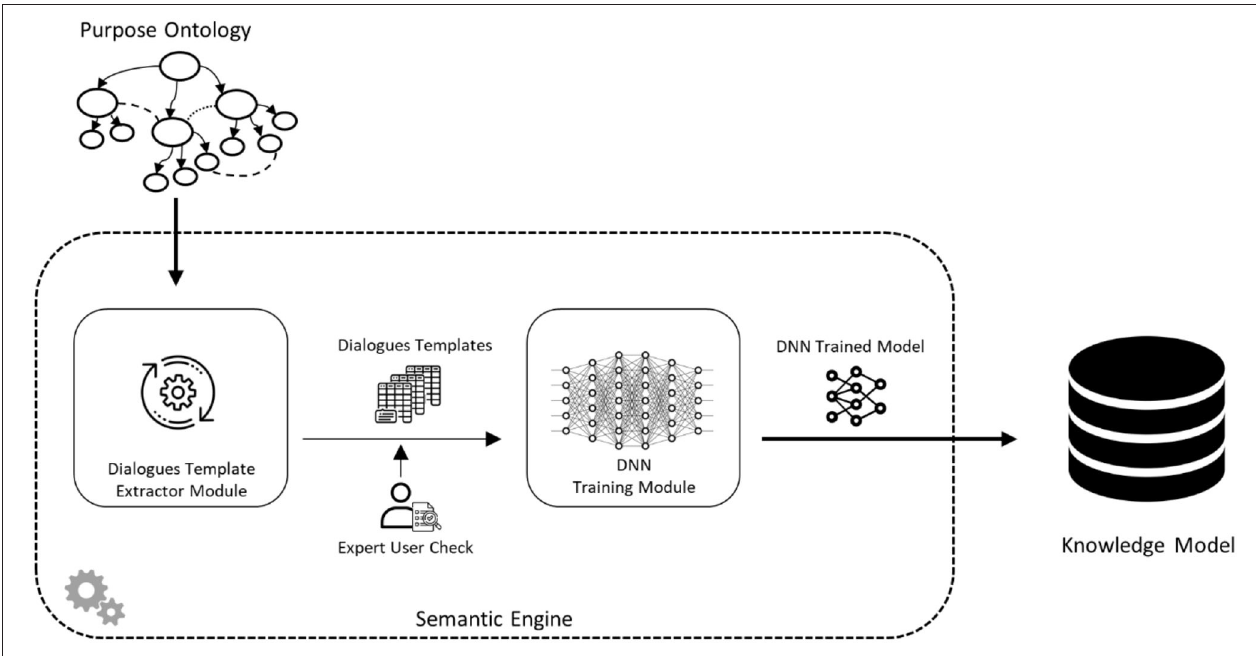
FIGURE 2 | System knowledge model workflow.